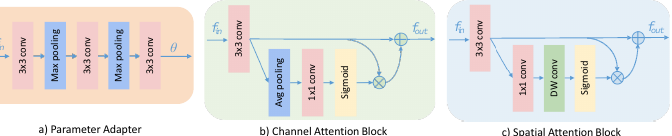
Figure 6. Illustration of the proposed parameter adapter, channel attention block, and spatial atten- tion